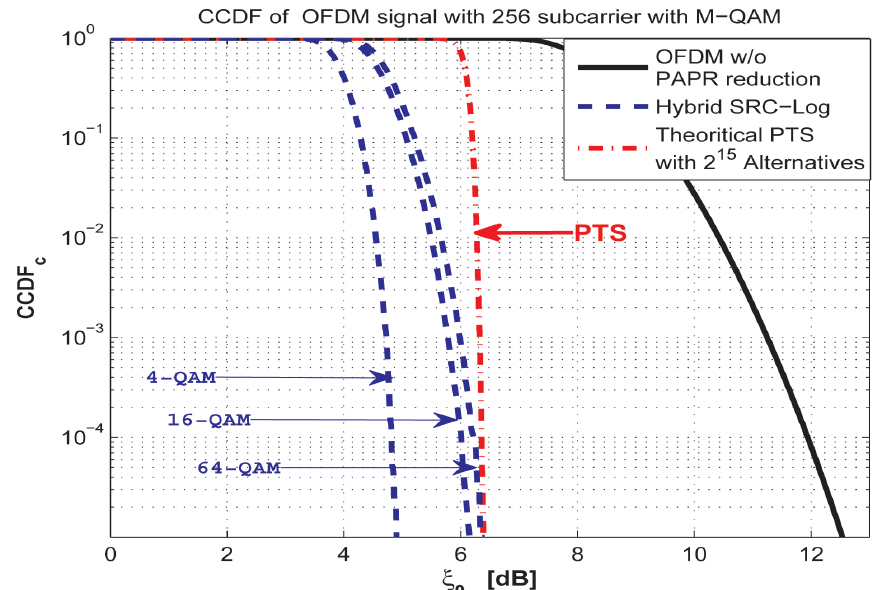
Figure 12. Comparison between SRC-Log and PTS with 215 alternatives. In the case of 4, 16, and 64-QAM.